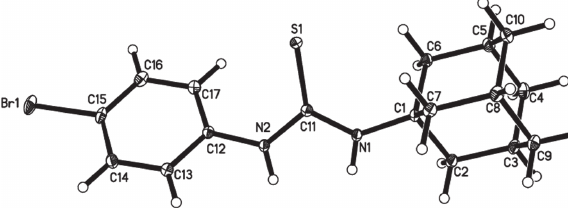
Table 1: Data collection and handling.